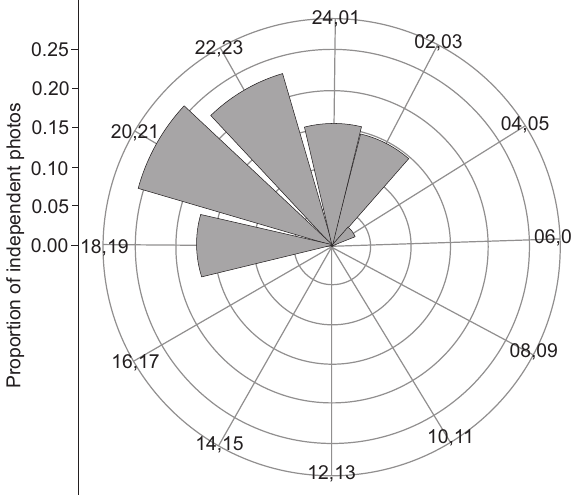
Figure 3. Proportion of independent Cuniculus paca photos recorded over a 24-hours cycle presented in 2-hours bins (e.g., “22, 23” inclu- des all photos between 22:00:00 and 23:59:59 h) obtained with camera traps in 19 forest fragments and five undisturbed areas of continuous forest sites surrounding the town of Alta Floresta, Mato Grosso,